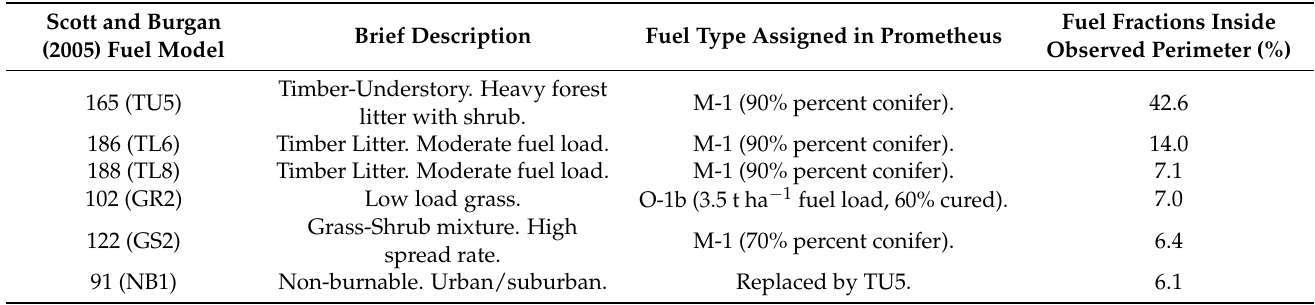
Table 1. Summary of Scott and Burgan [30] fuel models with a brief description, in the LANDFIRE dataset and conversion to Canadian FBP System fuel types [37,38] used in Prometheus, and their percentage within the 2018 Camp Fire observed burn perimeter. It is noted that the 3.5 t ha − 1 is grass fuel load default value in the FBP System (and in turn